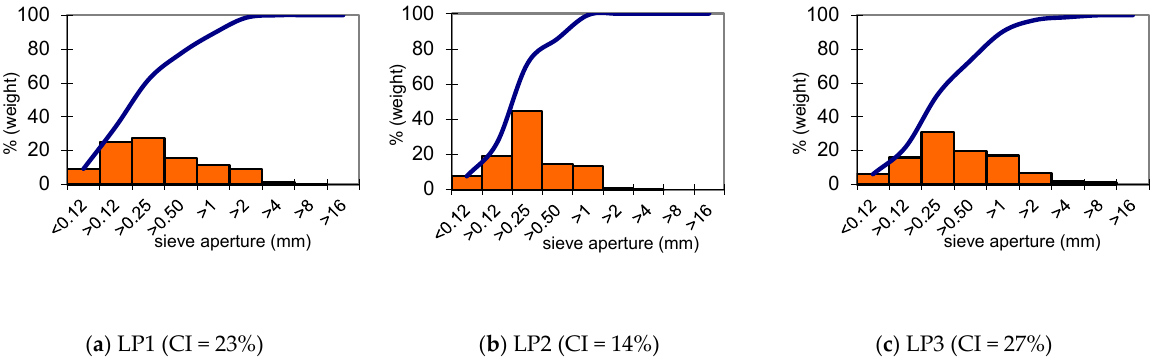
Figure 4. Grain-size distribution of the 3 samples collected in La Palma.